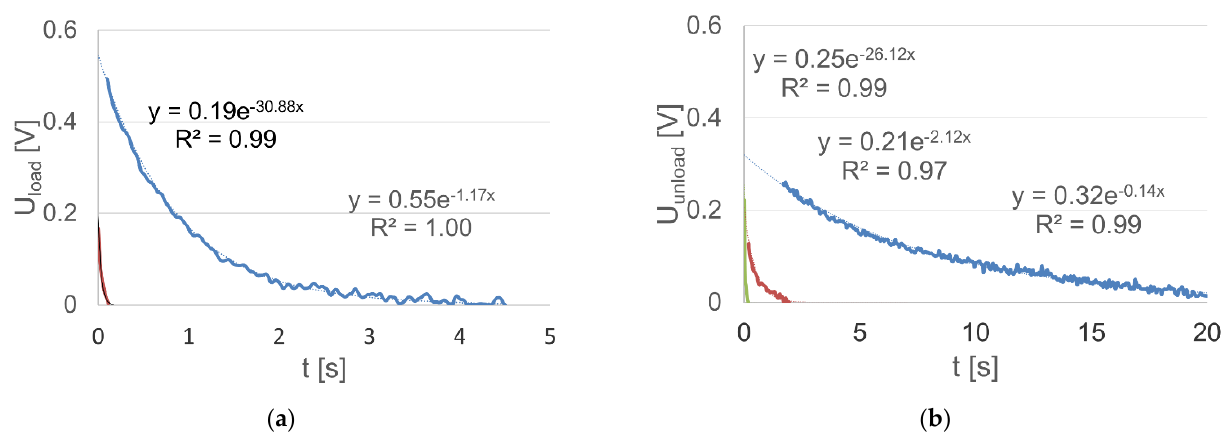
Figure 7. Determined voltage components at the terminals of the: ( a ) loaded battery within the time range up to 4.5 s (regression equations, mixture of exponential functions, are written in the text (16)); ( b ) unloaded battery within the time range up to 20 s (regression equations, mixture of exponential functions, are written in the text (17)).